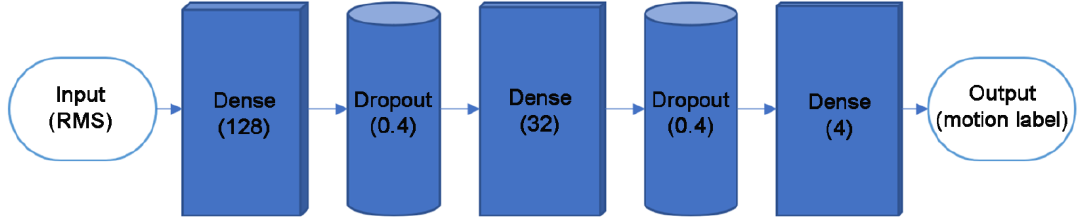
Figure 5. The structure of the neural network.